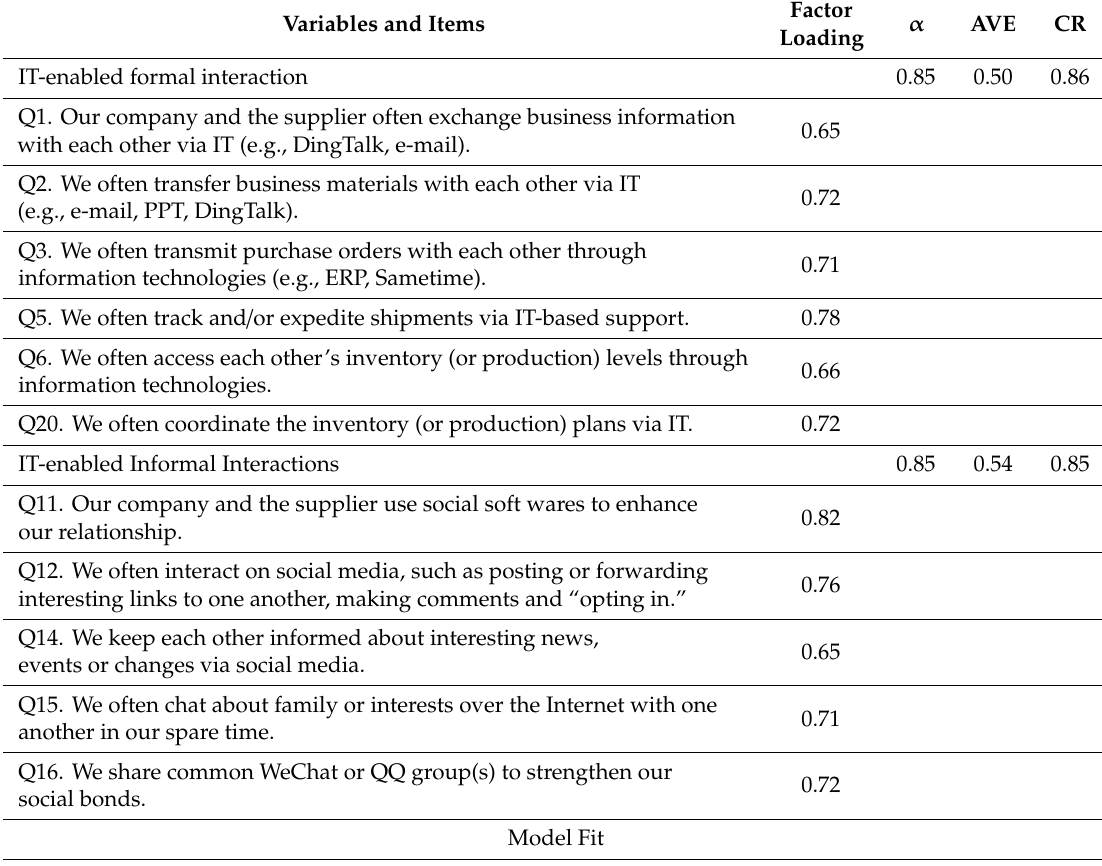
Table 5. The confirmatory factor analysis (CFA) results ( N =